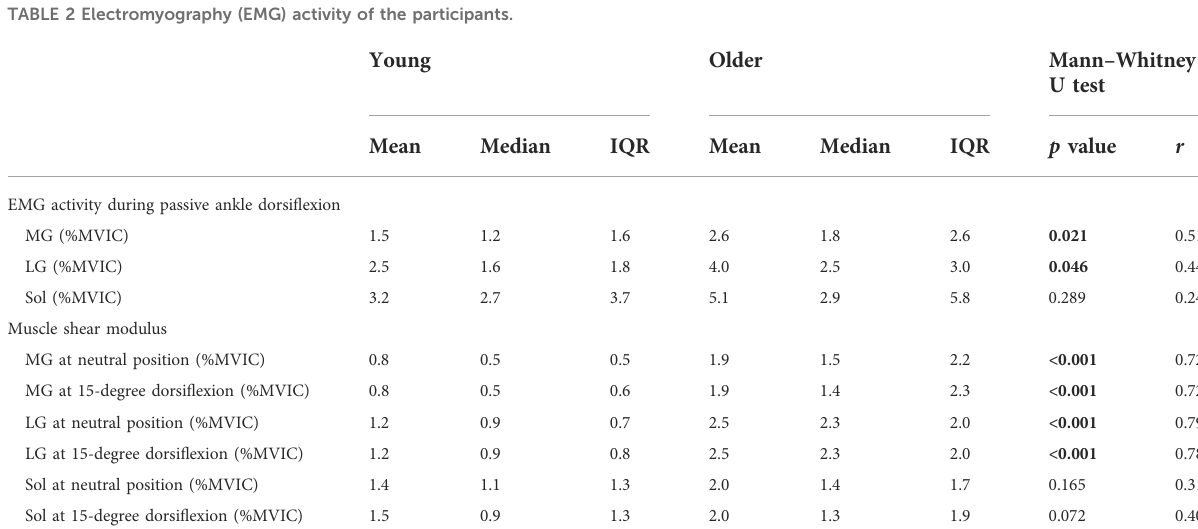
TABLE 2 Electromyography (EMG) activity of the participants.